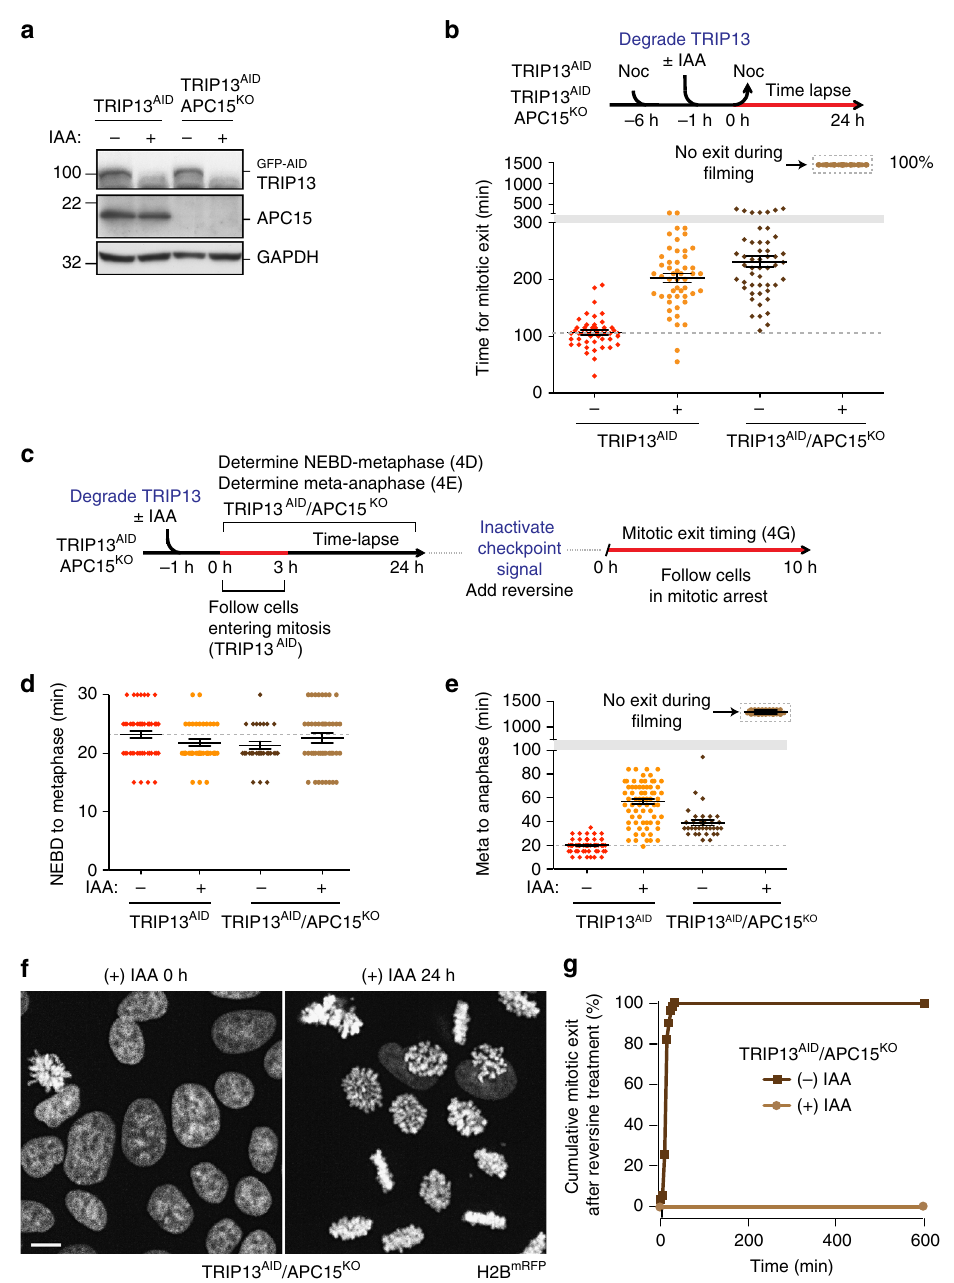
Fig. 3 TRIP13 and APC15 synergistically act on kinetochore-generated MCC. a Western blot showing effective depletion of GFP-AID-TRIP13 in TRIP13 AID and TRIP13 AID /APC15 KO cells. b Upper: Schematic of experiment to measure timing of mitotic exit after TRIP13 depletion by IAA addition. Lower: Timing of mitotic exit after 6-h nocodazole treatment, followed by release into DMEM. ( n = 50 for each experimental condition). c Schematic of approach to monitor unperturbed mitosis after depletion of TRIP13 (by IAA addition) in TRIP13 AID /APC15 KO cells (used in d – f ). d Unperturbed mitotic timing NEBD-to- metaphase; ( n = 50 for each experimental condition). e Metaphase-to-anaphase of TRIP13 AID and TRIP13 AID /APC15 KO cells entering mitosis 3 h after depletion of TRIP13. ( n = 70 for each experimental condition). f Representative images of chromosomes in TRIP13 AID /APC15 KO cells after before IAA treatment (left) and 24 h after IAA treatment (right). Scale bar, 5 μ m. g Mitotic exit timing after inhibition of kinetochore signaling. Reversine was added 24 h after the start of imaging to inactivate kinetochore signaling, and mitotic exit of cells previously arrested in mitosis was measured for 10 h. ( n = 70 for each experimental condition). Lines in b , d , and e represent the mean ±